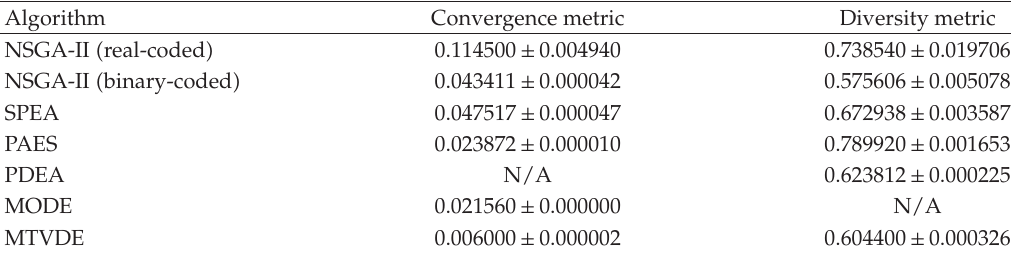
Table 3: Testing result’s statistics of the problem ZDT3.